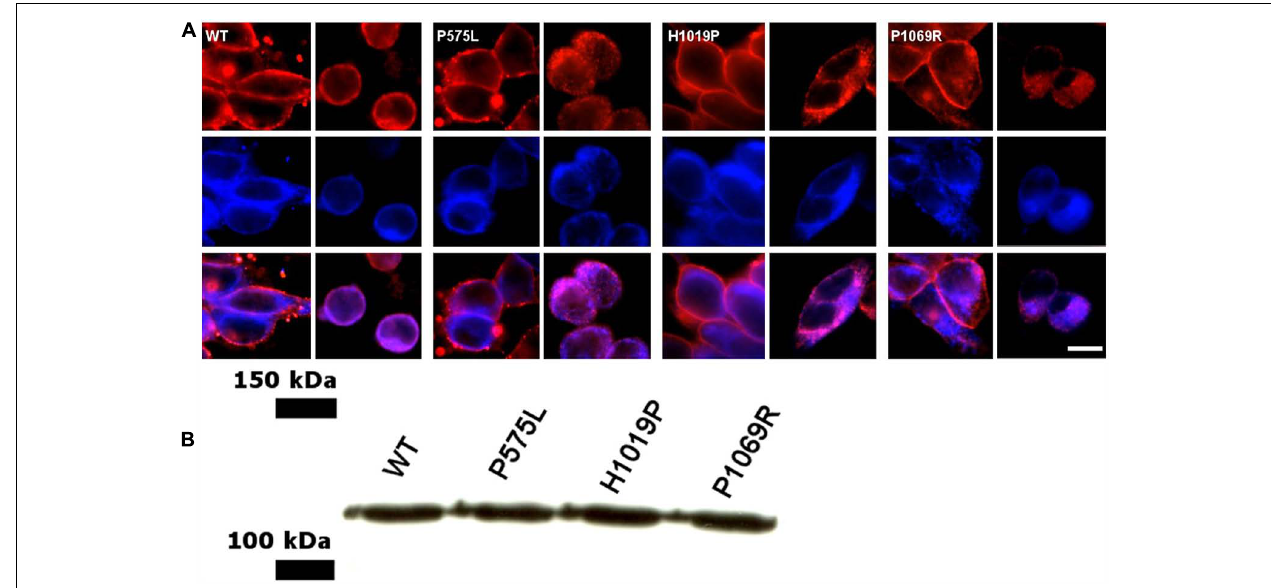
FIGURE 2 | CellularlocalizationofWTandROS-GC1mutantsinHEK293 cells.(A) CellswerestablytransfectedwithhumanROS-GC1constructsand wereprobedwithdifferentantibodies;thecorrespondingROS-GC1construct usedfortransfectionisindicatedinthecorneroftheupperleftpanel. Anti-Na + /K + -ATPasewasusedasplasmamembranemarker(upperleftpanel, redstaining);anti-calnexinantibodiesasmarkerfortheendoplasmicreticulum (toprightpanel,redstaining);anti-ROS-GC1antibody(middlepanels,blue staining);overlayofROS-GC1stainingandmembranespecificlocalization